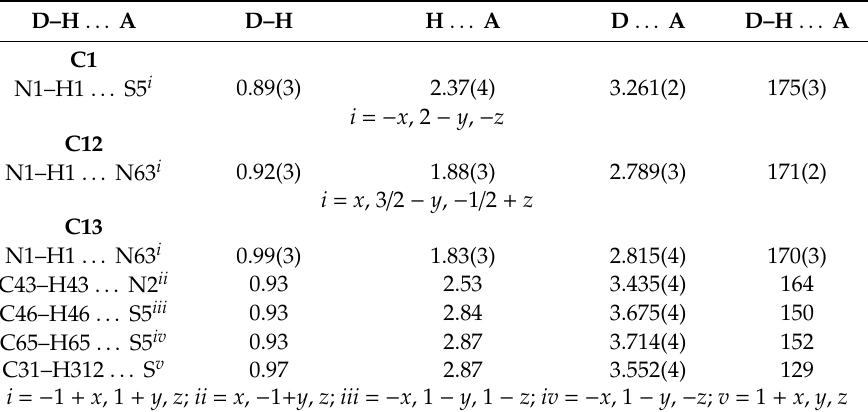
Table 1. Hydrogen-bond geometry (Å, ◦